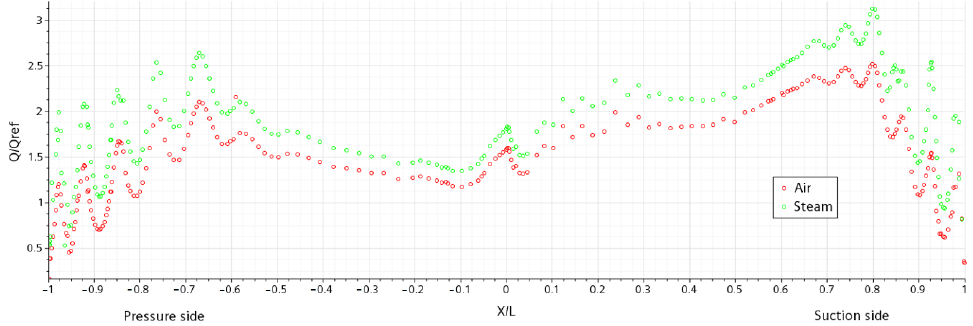
Figure 15. Comparison of normalised heat flux distribution at mid-span. The reference heat flux is 100,000 W/m 2 and is selected to normalise the